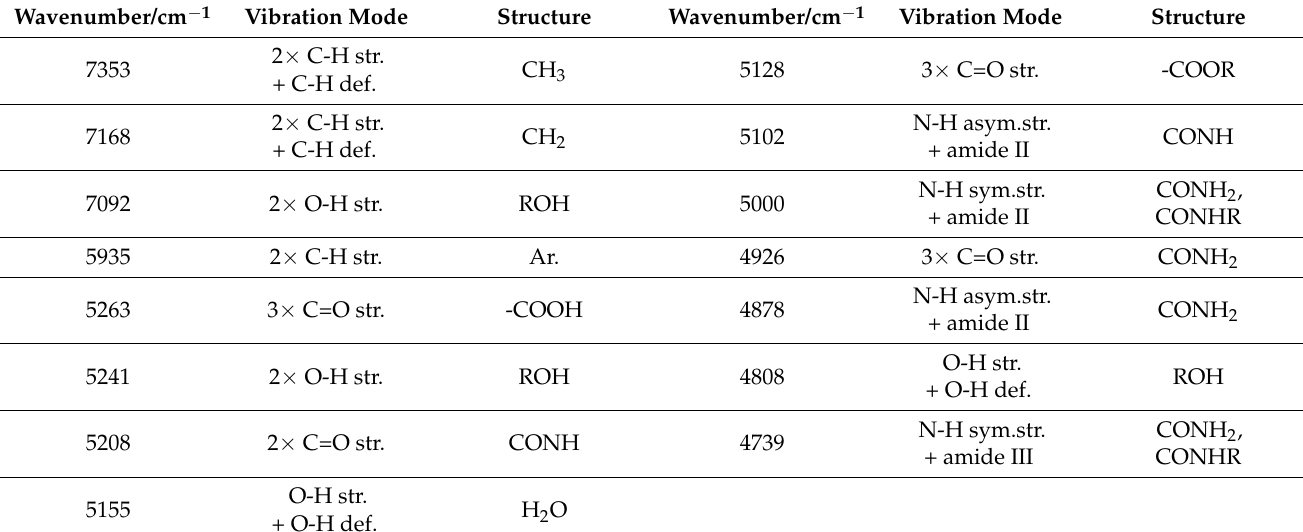
Symbol description in the table: “2 × ”, “3 × ”: the double and triple frequency of the fundamental frequency. “str.”, “def.”: stretching vibration and deformation vibration. “sym”, “asym.”: symmetrical vibration and asymmetrical vibration. “amide I (II, III)”: the different coupling modes of the carbonyl group and the amine group in the amide